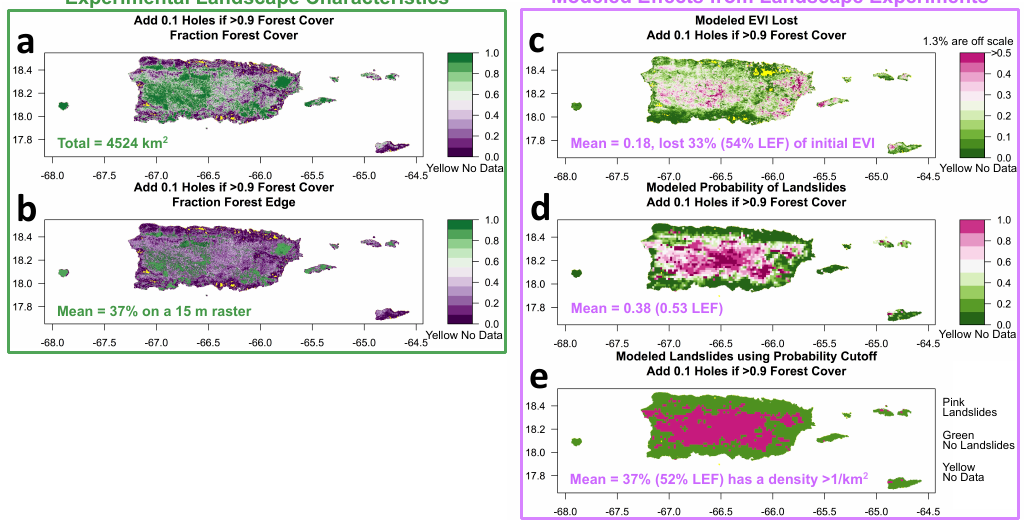
Figure 4. Experiment for future scenarios using increased fragmentation; altered landscape characteristics and resulting modeled effects. Plots of characteristics that were altered ( a , b ) list magnitude values and modeled effects plots ( c – e ) list mean regional values along with the Luquillo Experimental Forest (LEF) means. The cutoff probability of landslide occurring was set at 0.53 (plot d to e